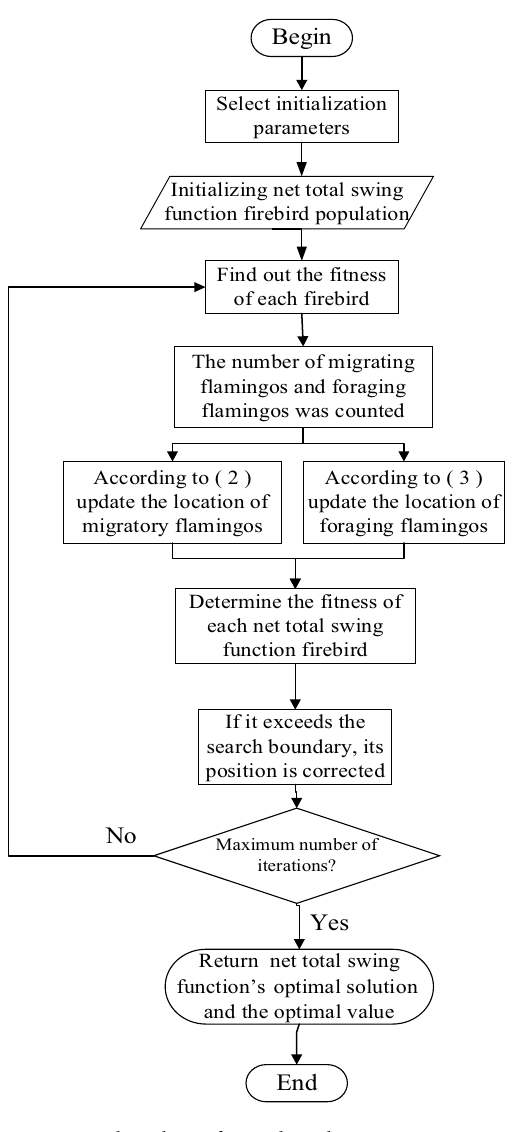
Figure 5. Flow chart of FSA